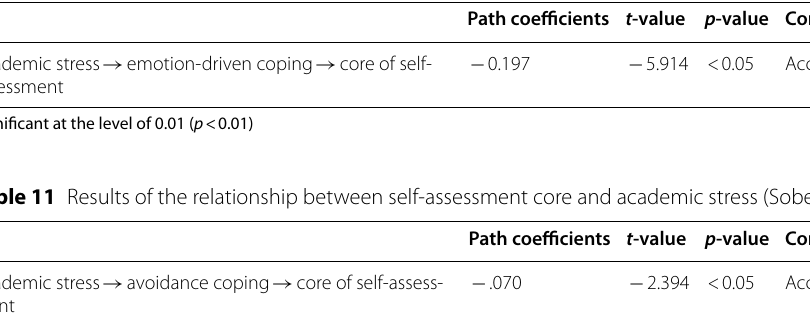
Table 10 Results of the relationship between self-assessment core and academic stress (Sobel test)